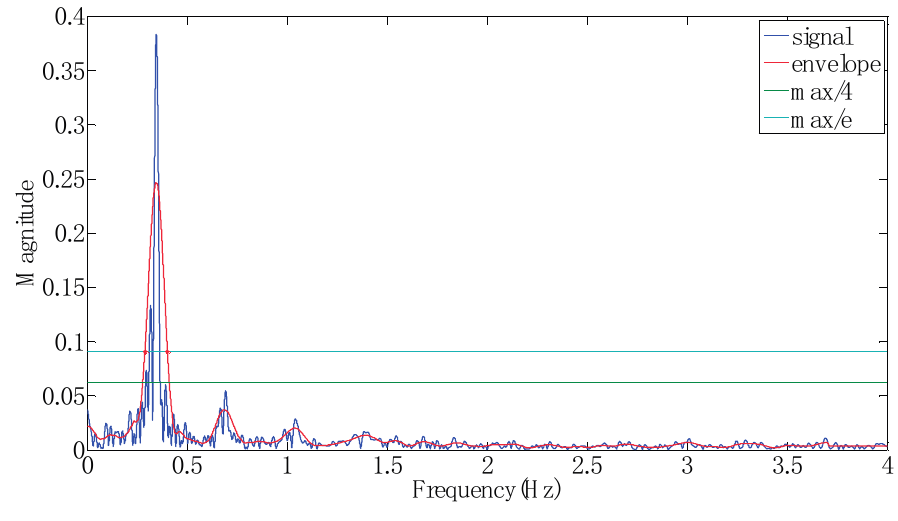
Figure 10. Enveloped and original spectra of frequency on the z axis of Ex.6 (spiral rotation exercise) after filtering.